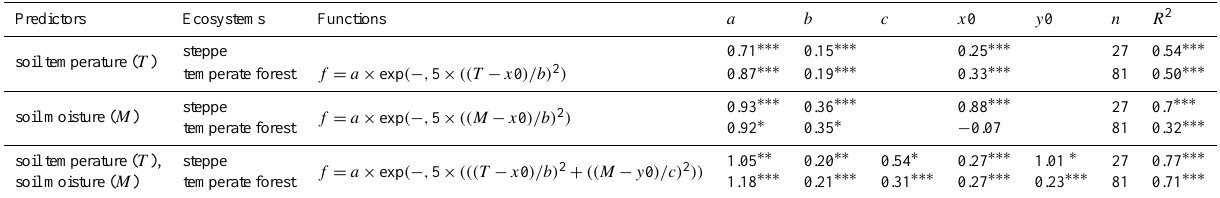
Table 5. Regression results between nitrous oxide fluxes and both soil temperature and soil moisture for freeze and thaw periods as observed in the dataset of the steppe site and the temperate forest site (only in the dataset of the year 1997).